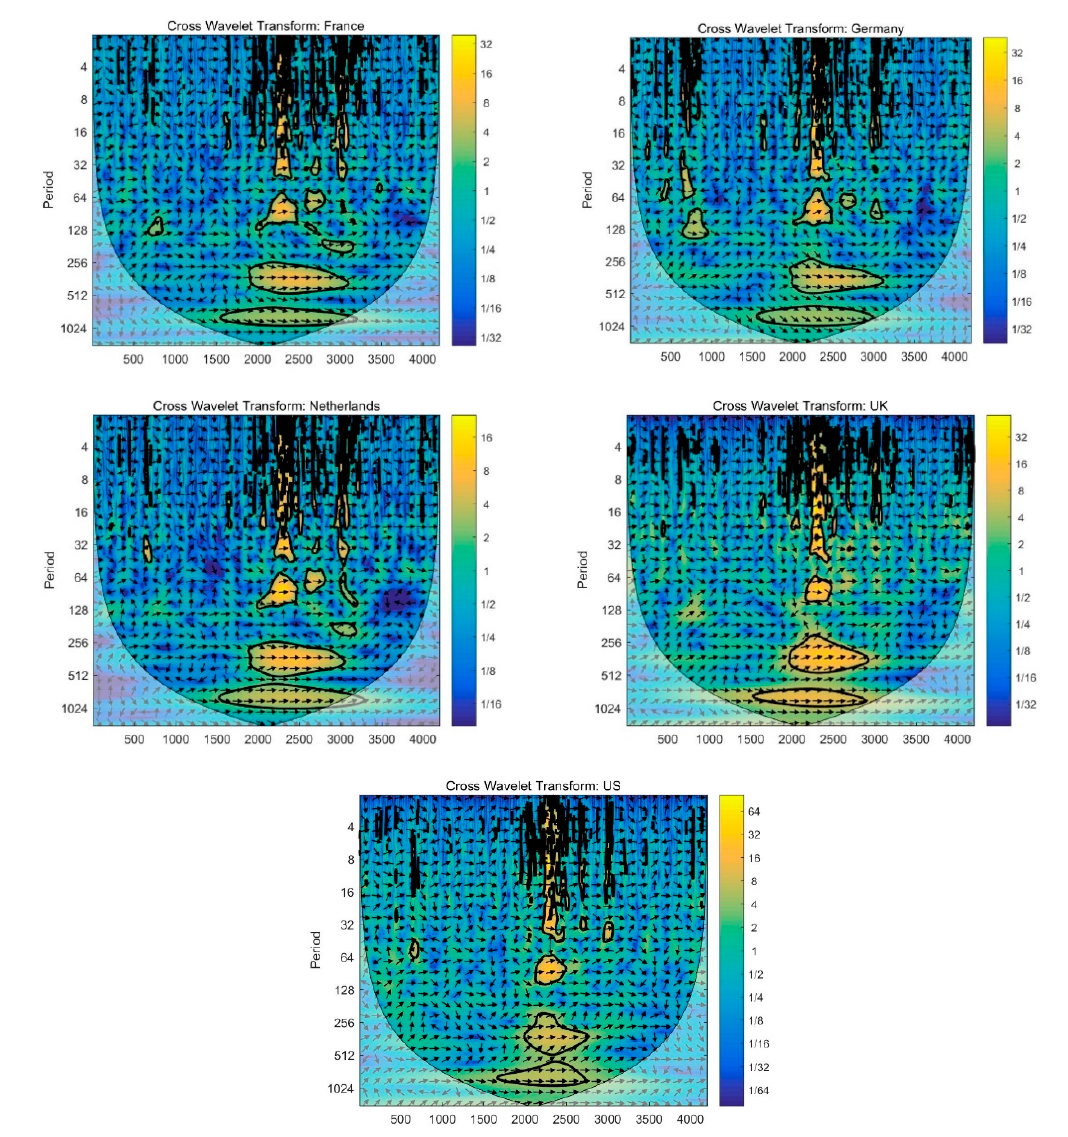
Figure 3. Cross wavelet (covariance) between securitized real estate and local stock markets. Notes: Contours are for cross wavelet spectrum (covariance) between stock and real estate markets. The color bar on the right-hand-side of each graph ranges from low co-spectrum (dark blue color) to high co-spectrum (yellow color). The thick dark lines indicate the 5% significant level for cross wavelet spectrum.